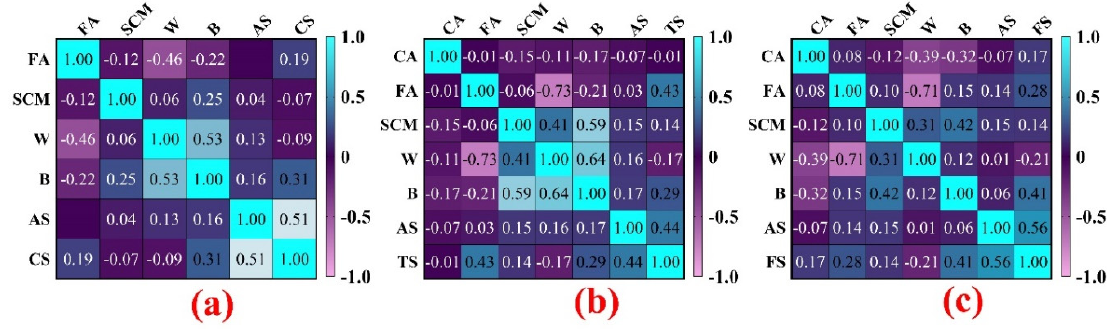
Figure 2. Correlation matrix of inputs and outputs; ( a ): CS, ( b ): TS, ( c ): FS.